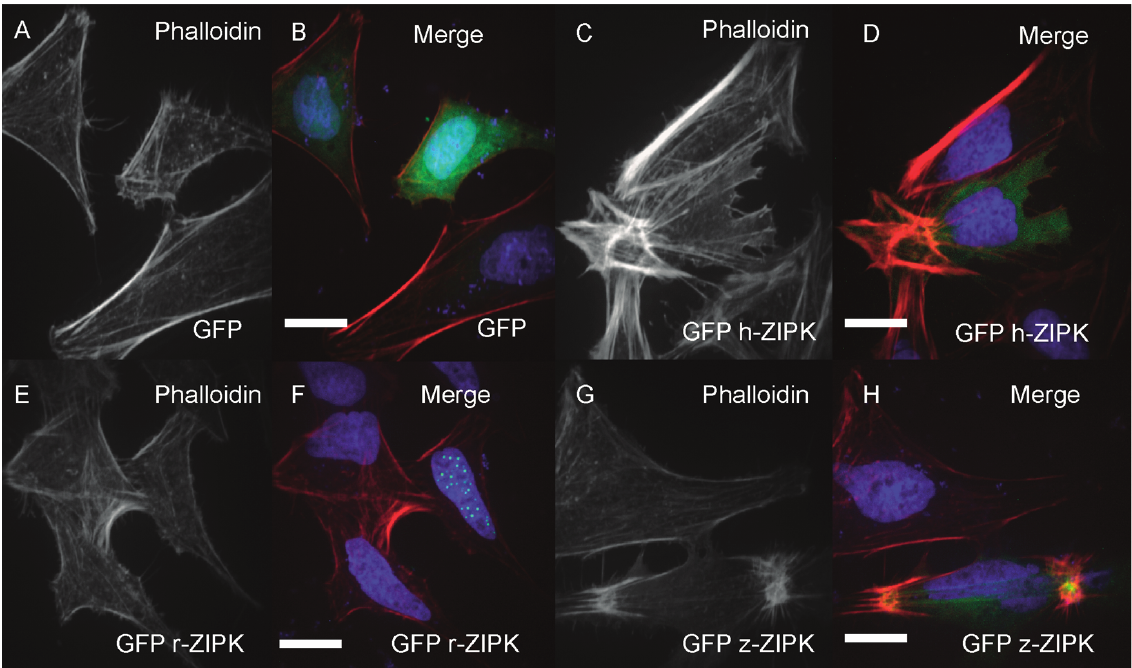
Figure 4. Differential regulation of the actin cytoskeleton by ZIPK homologs. HeLa cells were transfected with either GFP alone ( A , B ); human GFP-ZIPK ( C , D ); rat GFP-ZIPK ( E , F ); zebrafish GFP-ZIPK ( G , H ). All cells were fixed and stained with DAPI and Alexa 568-phalloidin and imaged with confocal microscopy. Black and white images show phalloidin staining, while color images are a merge of DAPI (blue), GFP (green) and phalloidin (red). Each experiment was replicated a minimum of five times with at least 25 cells assayed per experiment. White bar indicates 20 μ